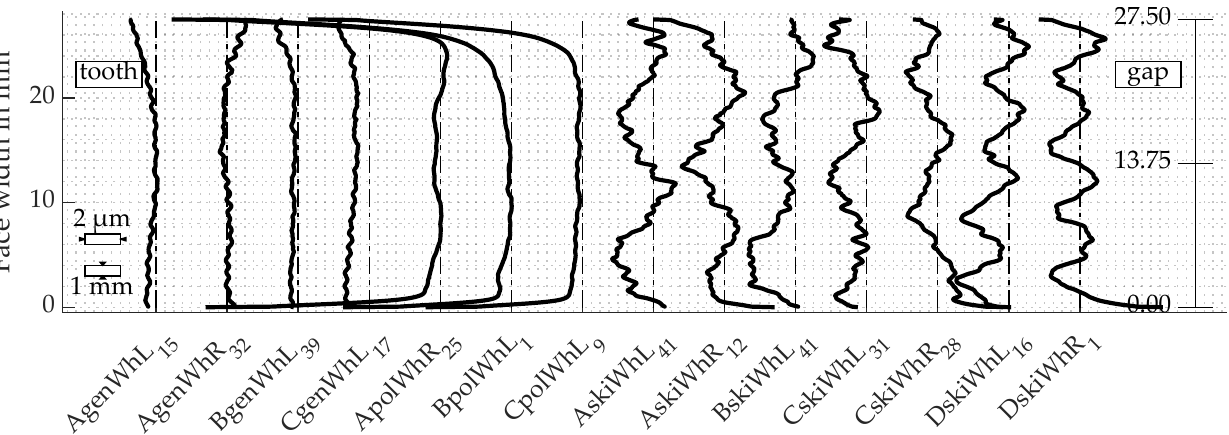
Figure 17. Lead lines of chosen teeth of all tested pinions.